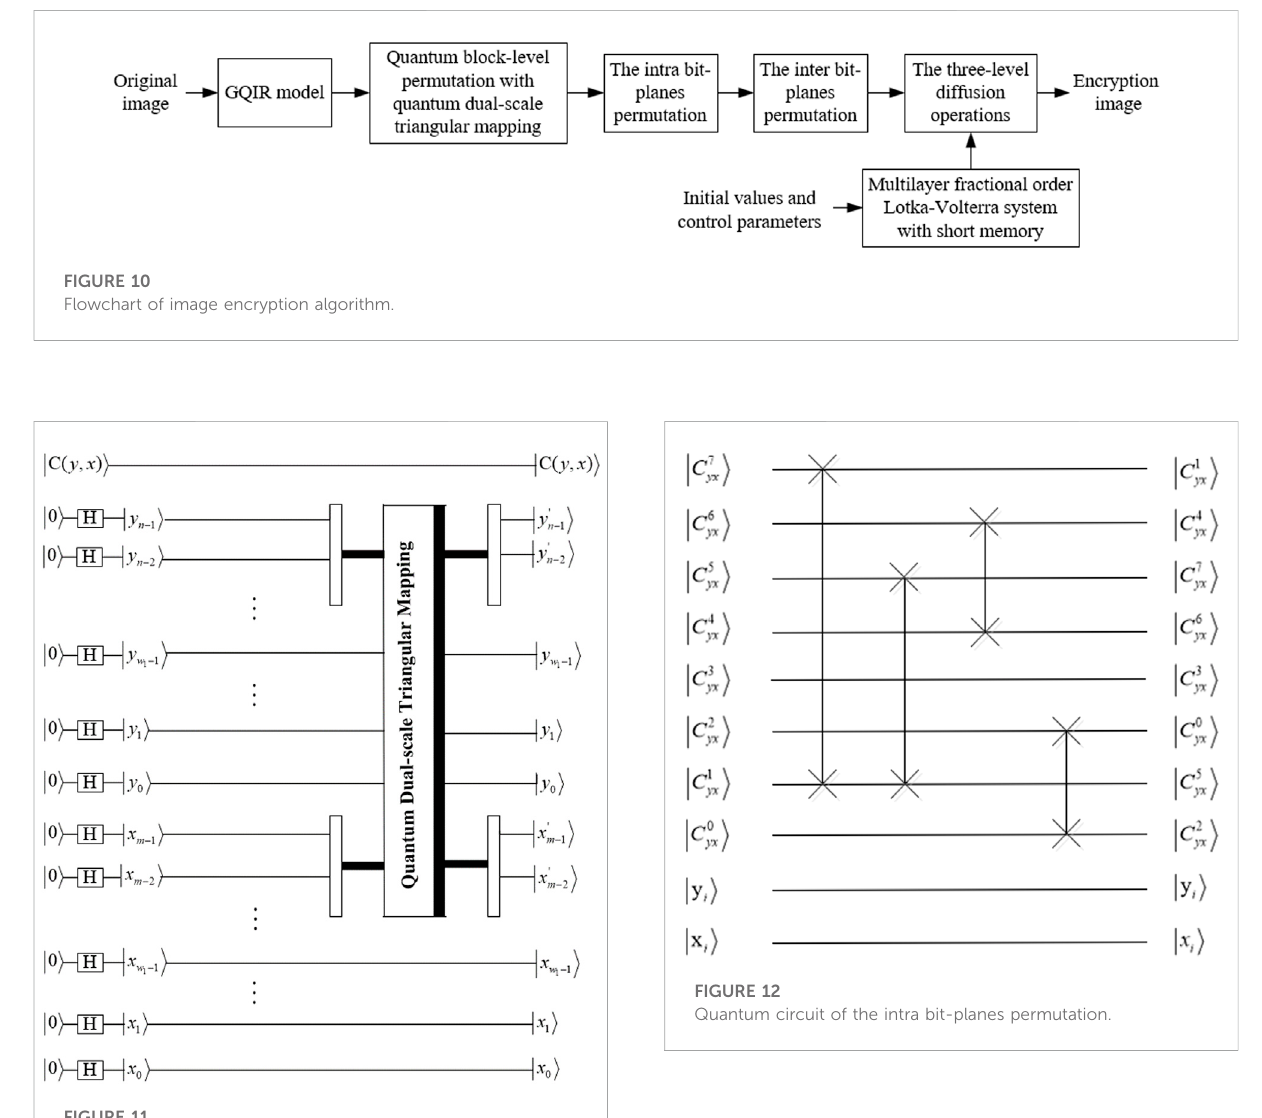
FIGURE 11 Quantum circuit for the block-level permutation based on Q dst .